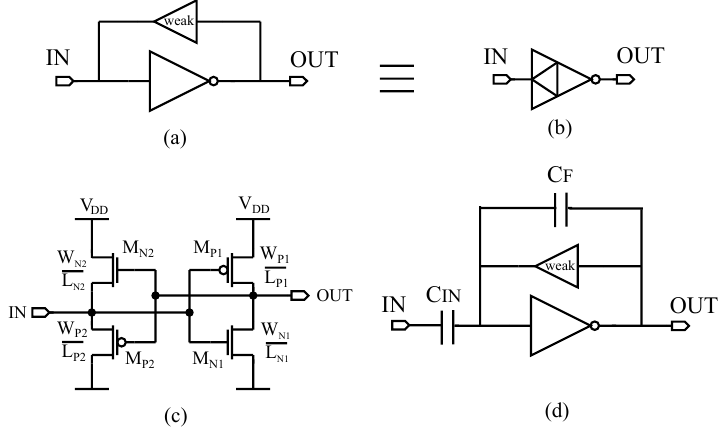
Figure 1. Pseudo-Floating Gate Amplifier (PFGA). ( a ) System Level. ( b ) Symbol for the PFGA [15] ( c ) Transistor Level. ( d ) PFGA with feedback and input